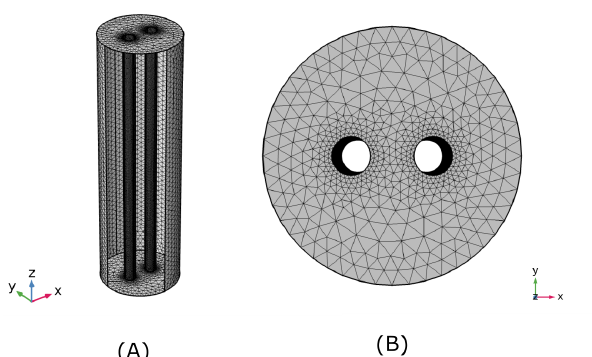
Figure 2. Configuration of the mesh for finite element simulation.( A ) Mesh ISO-View. ( B ) Mesh Top-view.